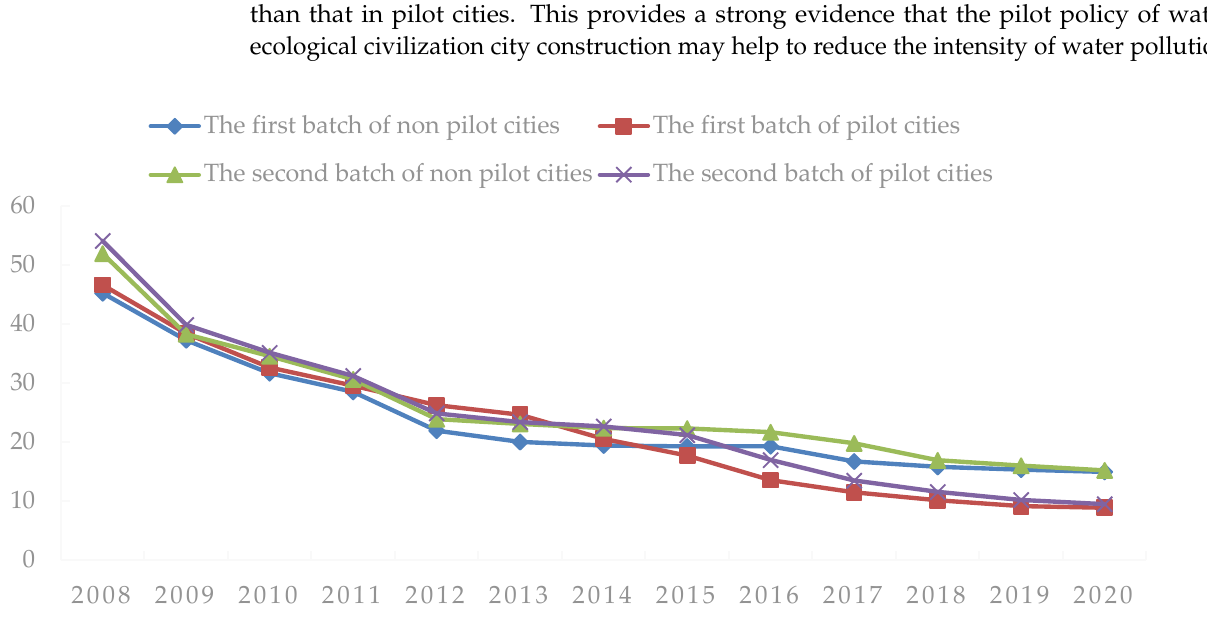
Figure 1. On the whole, before the pilot construction, the two batches of pilot cities and non-pilot cities show basically the same trend of water pollution intensity, with the non- pilot cities exhibiting a slightly lower water pollution intensity than the pilot cities. After